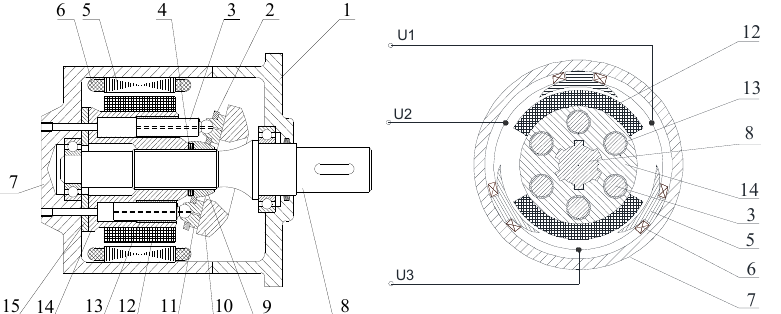
Figure 1. Schematic showing the structural principles of the electrohydraulic coupler. 1, front cover; 2, return disc; 3, plunger; 4, diaphragm spring; 5, stator core; 6, stator winding; 7, housing; 8, transmission shaft; 9, spherical spring seat; 10, swashplate; 11, slide shoe; 12, permanent magnet; 13, guide sleeve; 14, cylinder block; 15, distribution plate; U1, U2, U3, lead terminal.